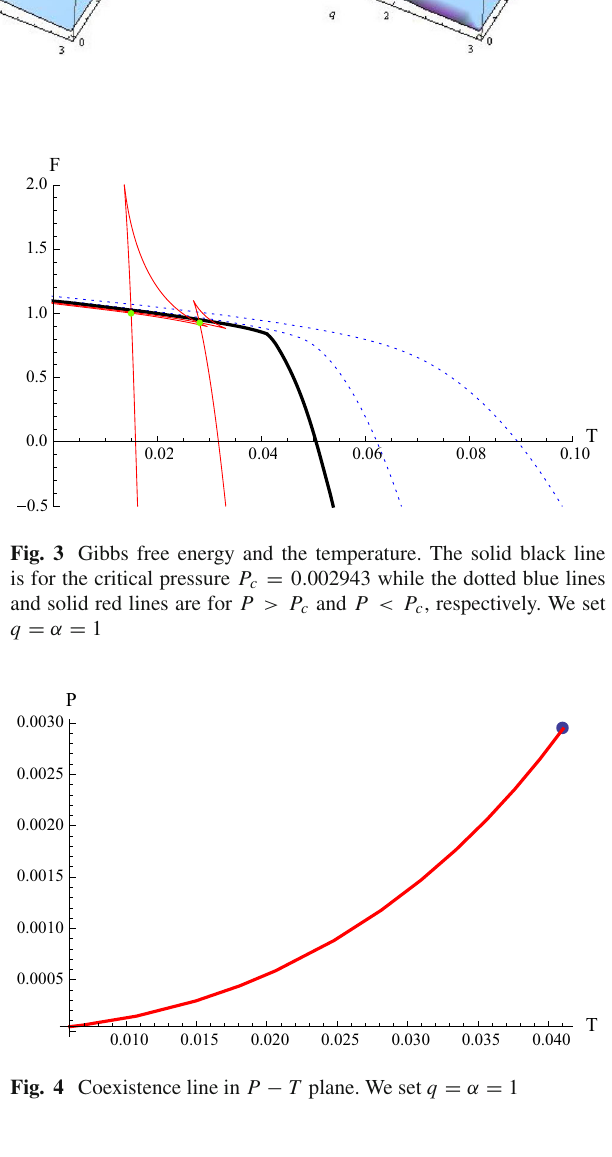
above which the small black hole is physically flavor while the large black hole is below the line. Our coexistence line with α = q = 1 is shown in Fig. 4 where the dot denotes , P ) . We note that for the first order phase transition, the ( T c c physical P − r h diagram should be modified by replacing the oscillating part by an isobar with the transition T = T 0